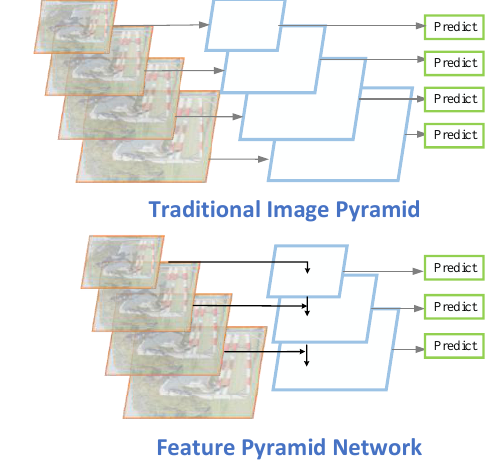
Figure 5 Traditional image pyramid and FPN When the feature pyramid network (FPN) is used [58], multi-scale information can be used, and the upsampling from the high-resolution feature layer can be combined with the feature layer information of the original scale. To make up for the loss of information caused by